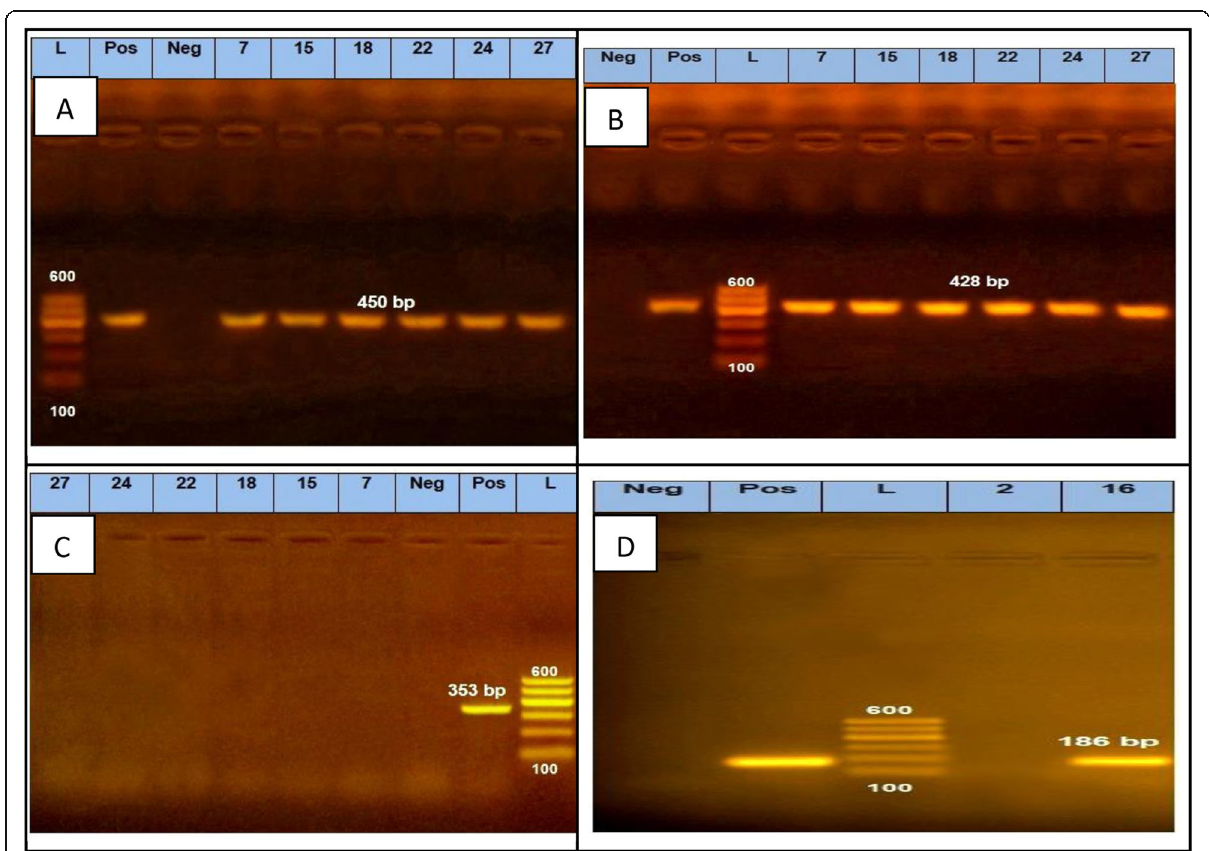
Fig. 5 Electrophoresis gel of PCR for detection of bacteriocins genes from the selected strains using primers pairs. a pln A. b pln EF. c pln C. d mes Y. Lane L, 1000 bp ladder. Lane Neg, negative control. Lane Pos, positive